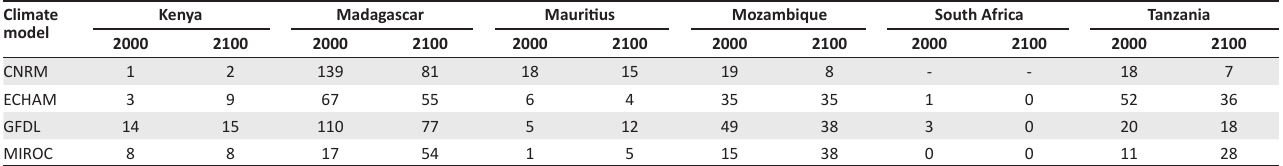
TABLE 3: Current and future global damages from tropical storms with no climate change. Climate